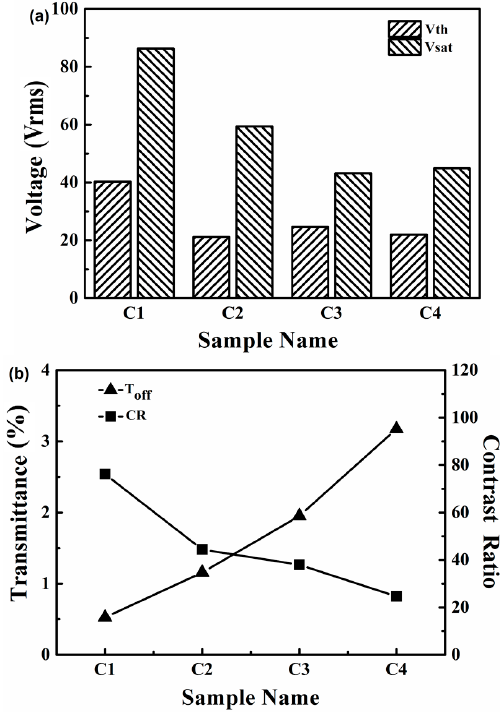
Figure 9. ( a ) Vth and Vsat of samples C1–C4; ( b ) Toff and CR of samples C1–C4.